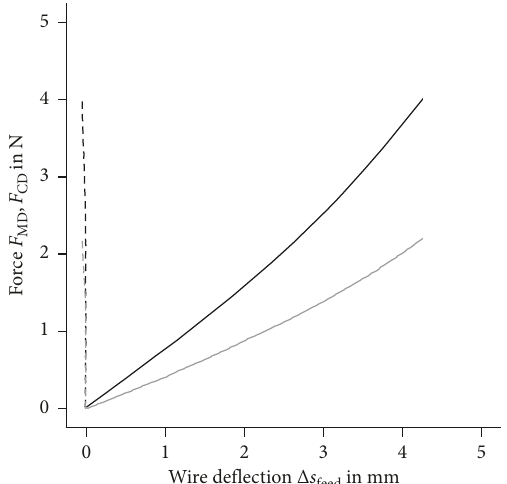
Figure 7: Plot of forces with respect to the feed difference with λ � 30 ° . The black continuous and dotted lines represent F MD for measured and corrected trace. The grey solid and dotted lines represent F CD for the measured and corrected trace.